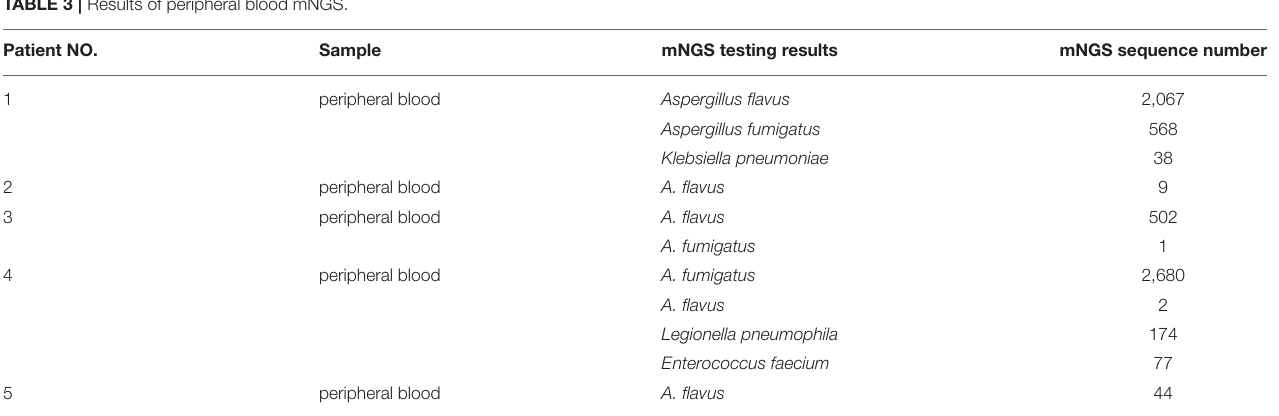
TABLE 3 | Results of peripheral blood mNGS. Patient